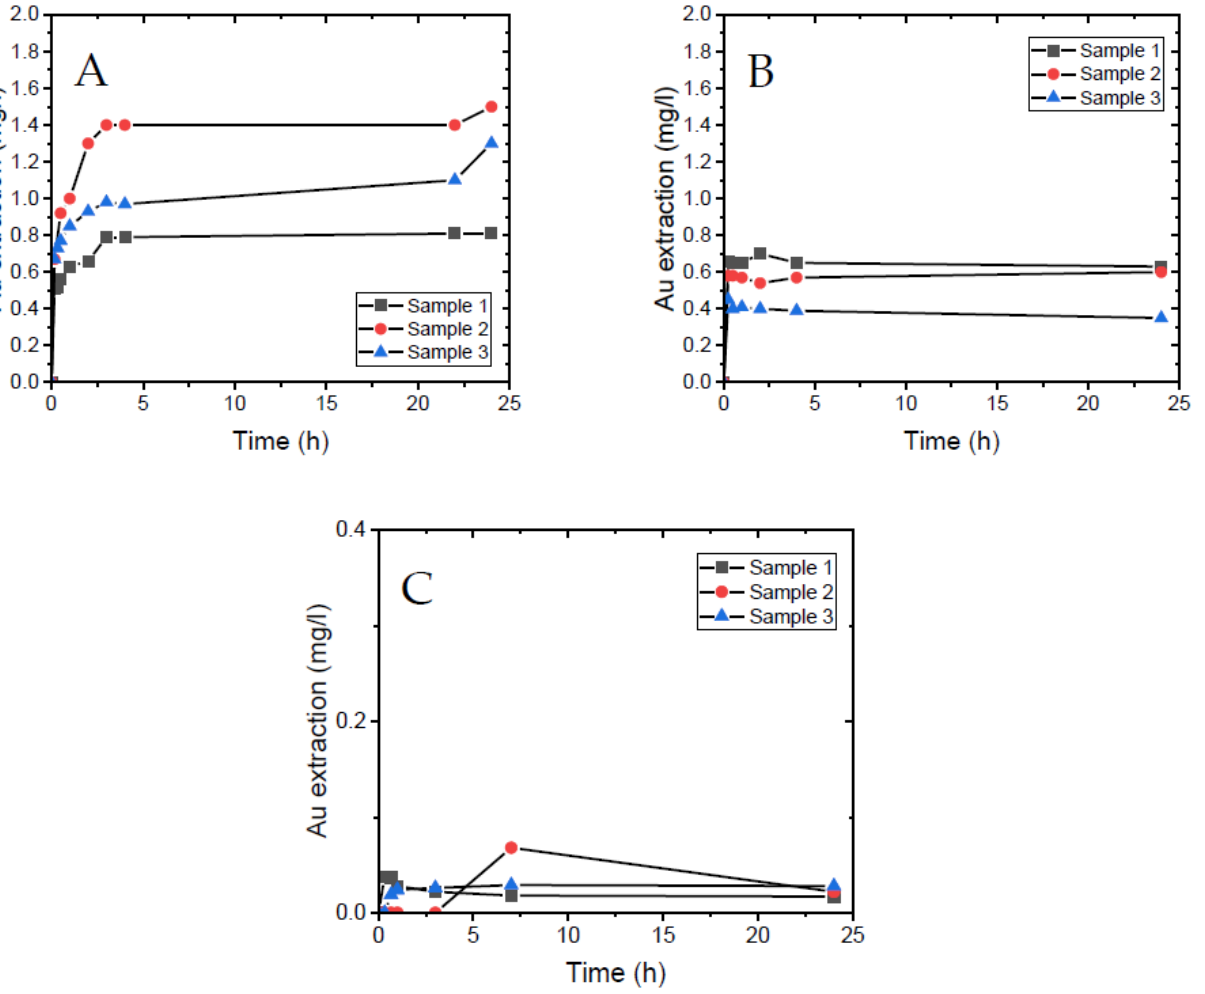
Figure 5. Cyanide leaching using 20 g/L NaCN ( A ) stage 2, ( B ) stage 4, and ( C ) stage 6. H 2 SO 4 leach results in stage 5 did not release any additional gold, which is expected